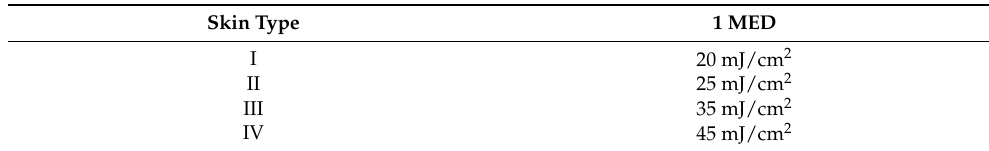
Table 4. MED values per skin type as defined by COST-713 [16].